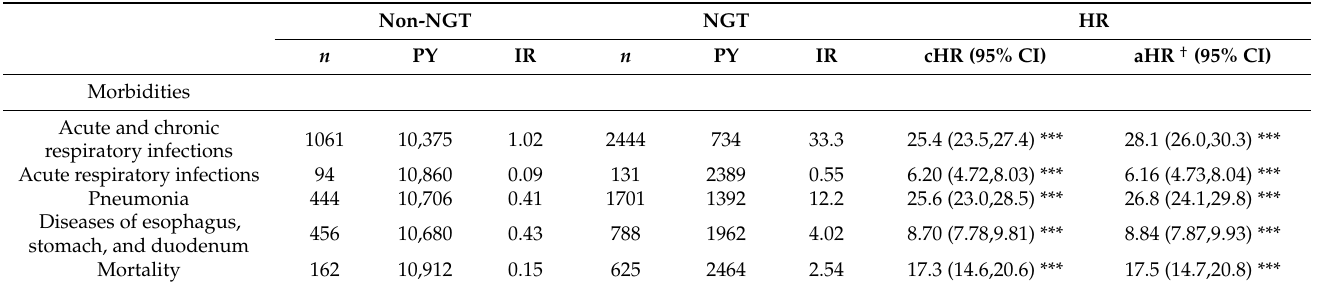
TBI: traumatic brain injury; PD: Parkinson’s disease. The data in Table 3 indicate that all outcomes increased in patients with long-term NGT placement compared with the controls. The adjusted HRs for acute and chronic respiratory infections, acute respiratory infections, pneumonia, diseases of the esophagus, stomach, and duodenum, and mortality were 28.1 (95% CI = 26.0, 30.3), 6.16 (95% CI = 4.73. 8.04), 26.8 (95% CI = 24.1, 29.8), 8.84 (95% CI = 7.87, 9.93), and 17.5 (95% CI = 14.7, 20.8), respectively. Figure 3 demonstrates that the 12-month cumulative incidence curves for each outcome were significantly higher in the NGT cohort than in the non-NGT cohort (log-rank test, p < 0.001). The patients with NGT placement for more than 6 months had a higher OR (1.58, 95% CI = 1.13, 2.20) for pneumonia than those with NGT placement for less than 6 months (Table 4). Table 3. The outcomes within one year.